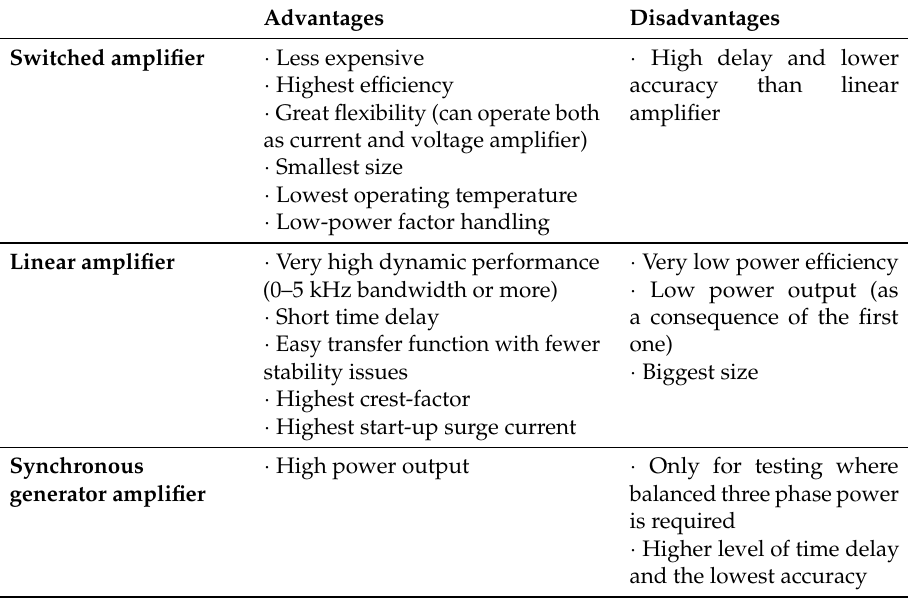
Table 1. Advantages and disadvantages of different types of power amplifiers